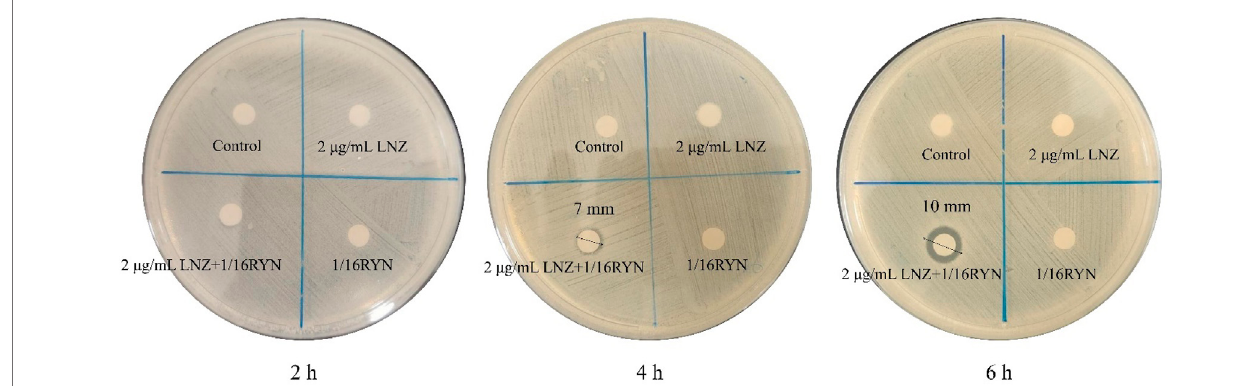
FIGURE 3 | Effect ofLNZ and RYN on the permeability ofMRSA bio fi lms. There was no bacteriostatic zone in the control group, 2 μ g/ml LNZ group and 1/16RYN group, but the bacteriostatic zone in the 2 μ g/ml LNZ+1/16RYN group increased with the extension of action time [2 h (6 mm) < 4 h (7 mm) < 6 h (10 mm)].